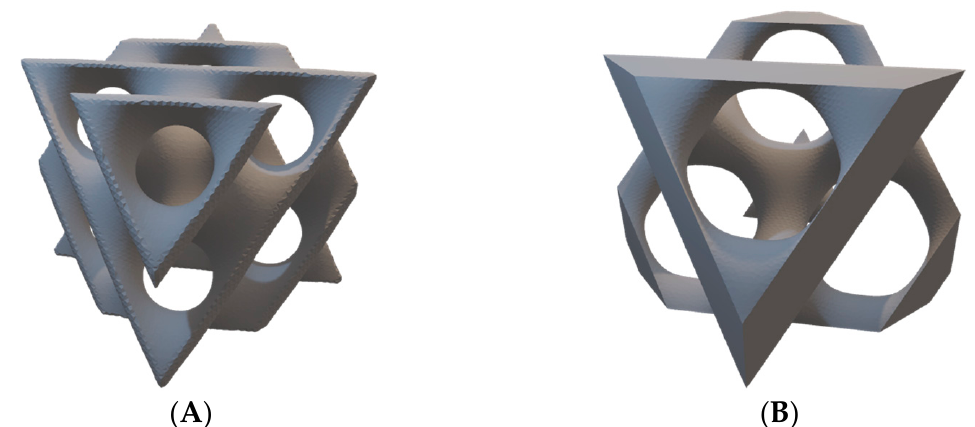
Figure 1. Three-dimensional models of Diamond unit cell: ( A ) sheet (matrix, shell); ( B ) skeletal (net- work).